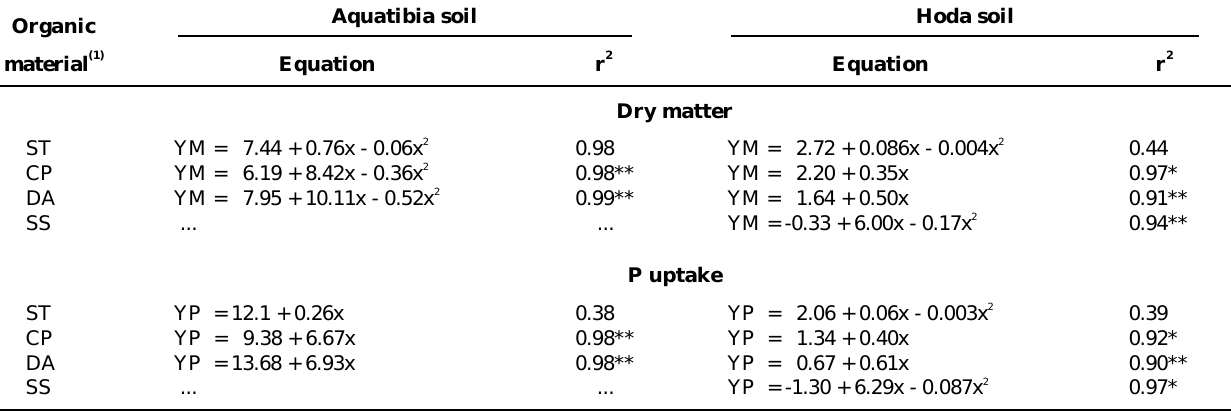
Table 3. Regression equations and determination coefficients obtained for dry matter yield (YM) and P uptake (YP) as a function of the amounts of organic materials added to Aquatibia and Hoda soils (x)